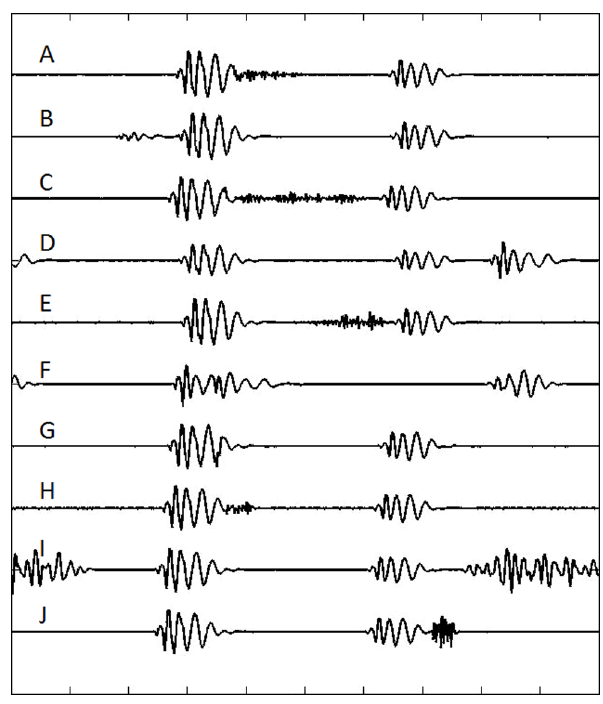
Figure 7. Example heart sounds used in the tests. A – early systolic murmur, B – S4, C – pansystolic murmur, D – S3, E – late systolic murmur, F – normal split S2, G – normal split S1, H – ejection click, I – diastolic rumble, J – opening